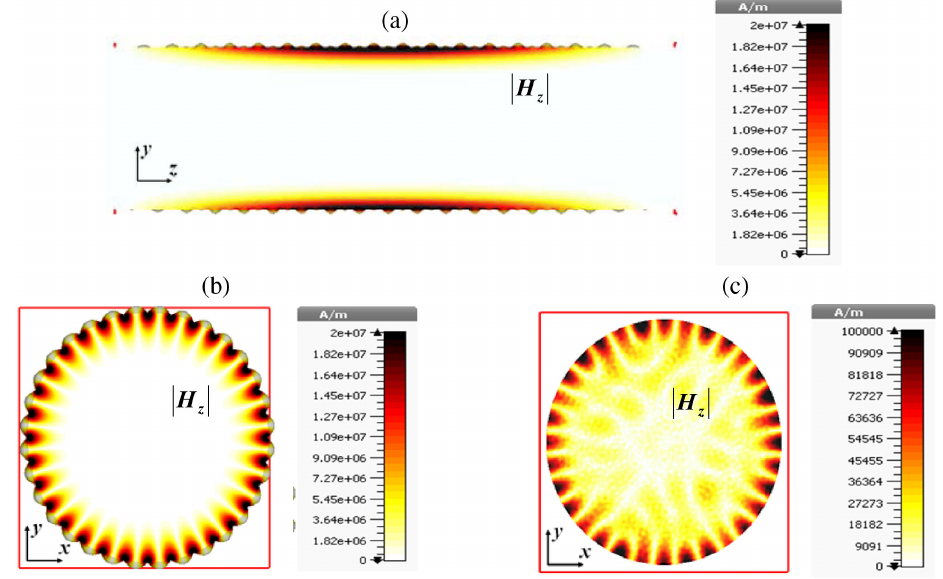
FIG. 13. CST PIC simulations of the sub-GW Ka-band 2D SWO (SINUS-6 accelerator): H correspond to interference of transversely (azimuthally) propagating partial wave beams output (c) cross sections of the waveguide.